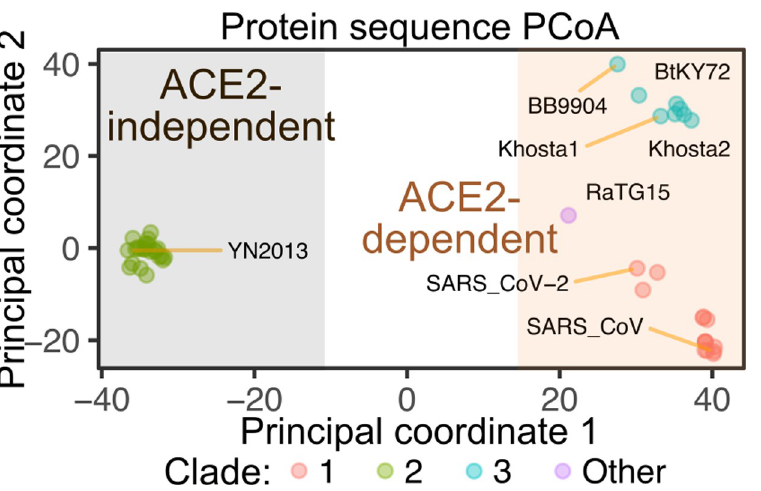
Fig 8. Summary of RBD protein sequence space and ACE2 utilization. The Hamming distance matrix for sarbecovirus RBD protein sequences was used for a principal coordinate analysis. The first 2 principal coordinates are shown as X and Y axes, generating a scatter plot based on RBD sequence dissimilarity. Proposed delineation of ACE2-dependent and ACE2-independent RBDs based on differences in protein sequence are shown, with each clade given a different color. The underlying data can be found in S2 Data, and the source code can be found at https:// github.com/MatreyekLab/ACE2_dependence. ACE2, angiotensin converting enzyme-2; RBD, receptor binding